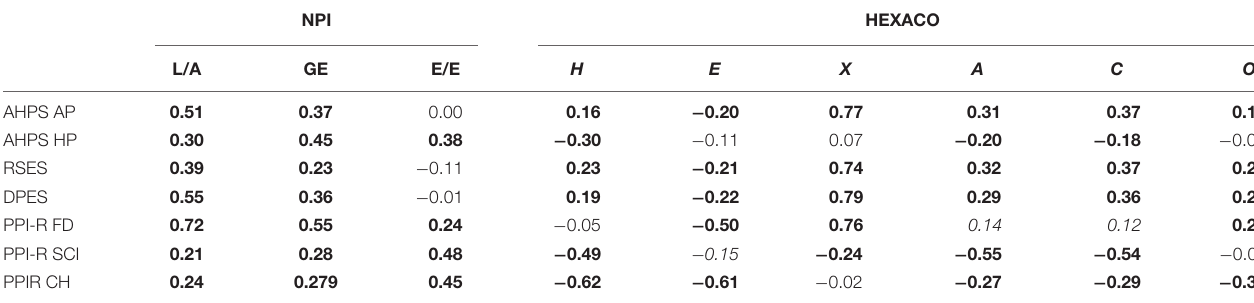
TABLE 2 | Correlations between pride, psychopathy, narcissism, and general